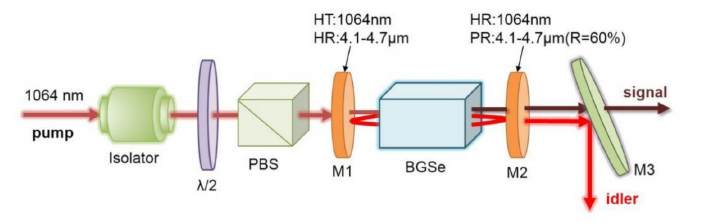
Figure 2. Schematic diagram of the experimental setup.